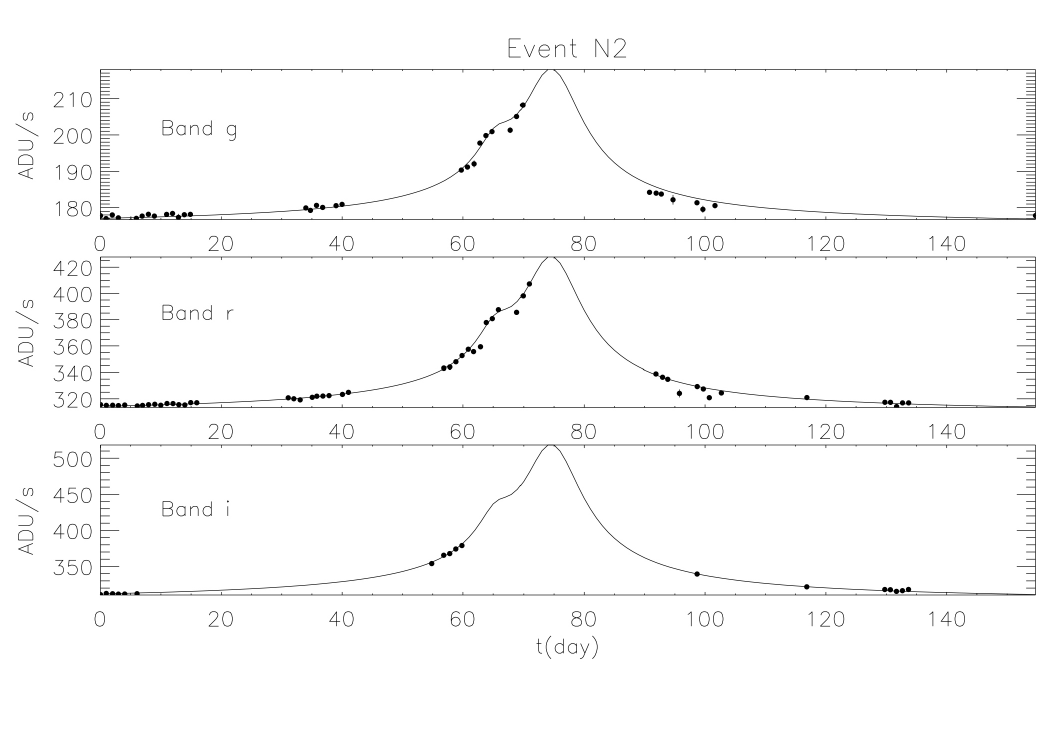
Figure 5. Light curve in three different bands (g, r and i) of the PA99-N2 event detected in 1999 toward the Andromeda